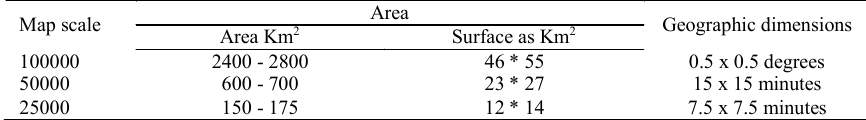
Table 7: Standard maps in terms of scale, size and